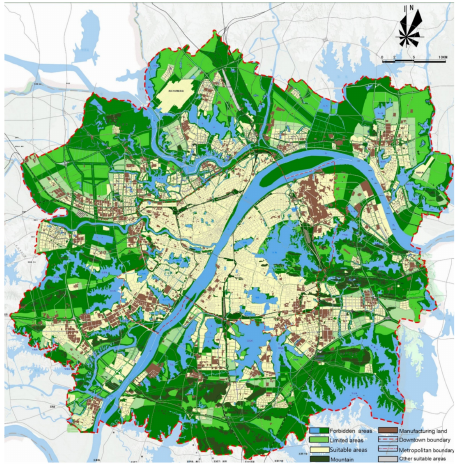
Figure 9. Overlap of the area within the eco-environmental bottom line and current manufacturing land in the Wuhan metropolitan